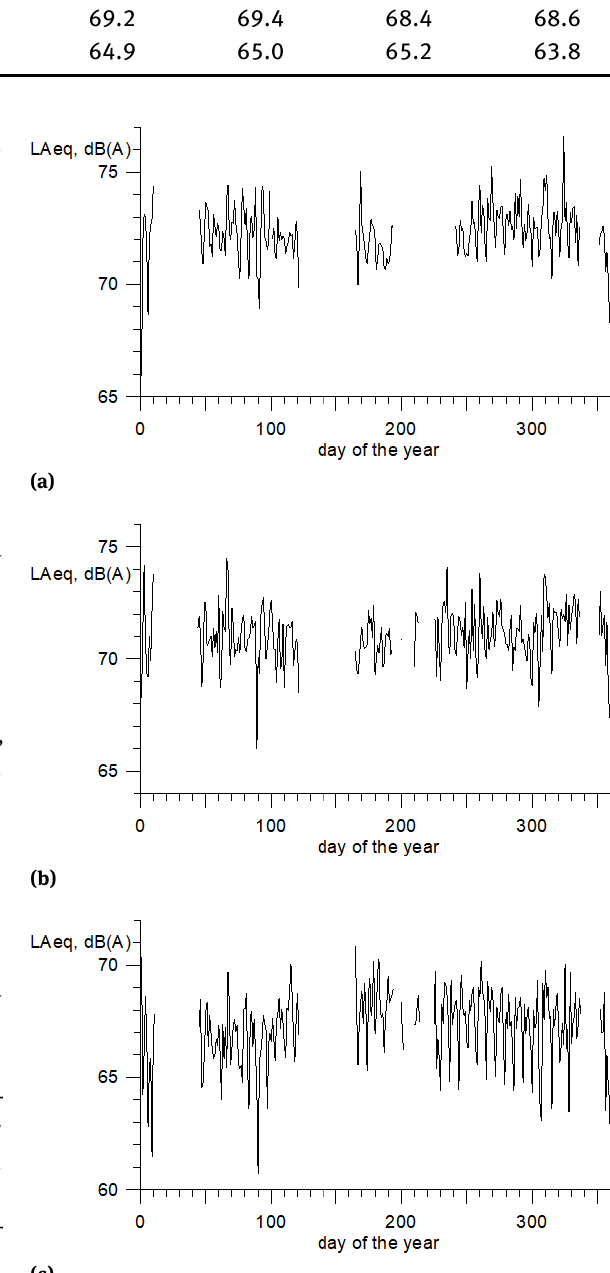
Figure 3: L Aeq calculated from measurements made at the location no. 2, in year 2013, for: (a) day sub-interval (6-18), (b) evening (18- 22), and (c) night (22-6) in year